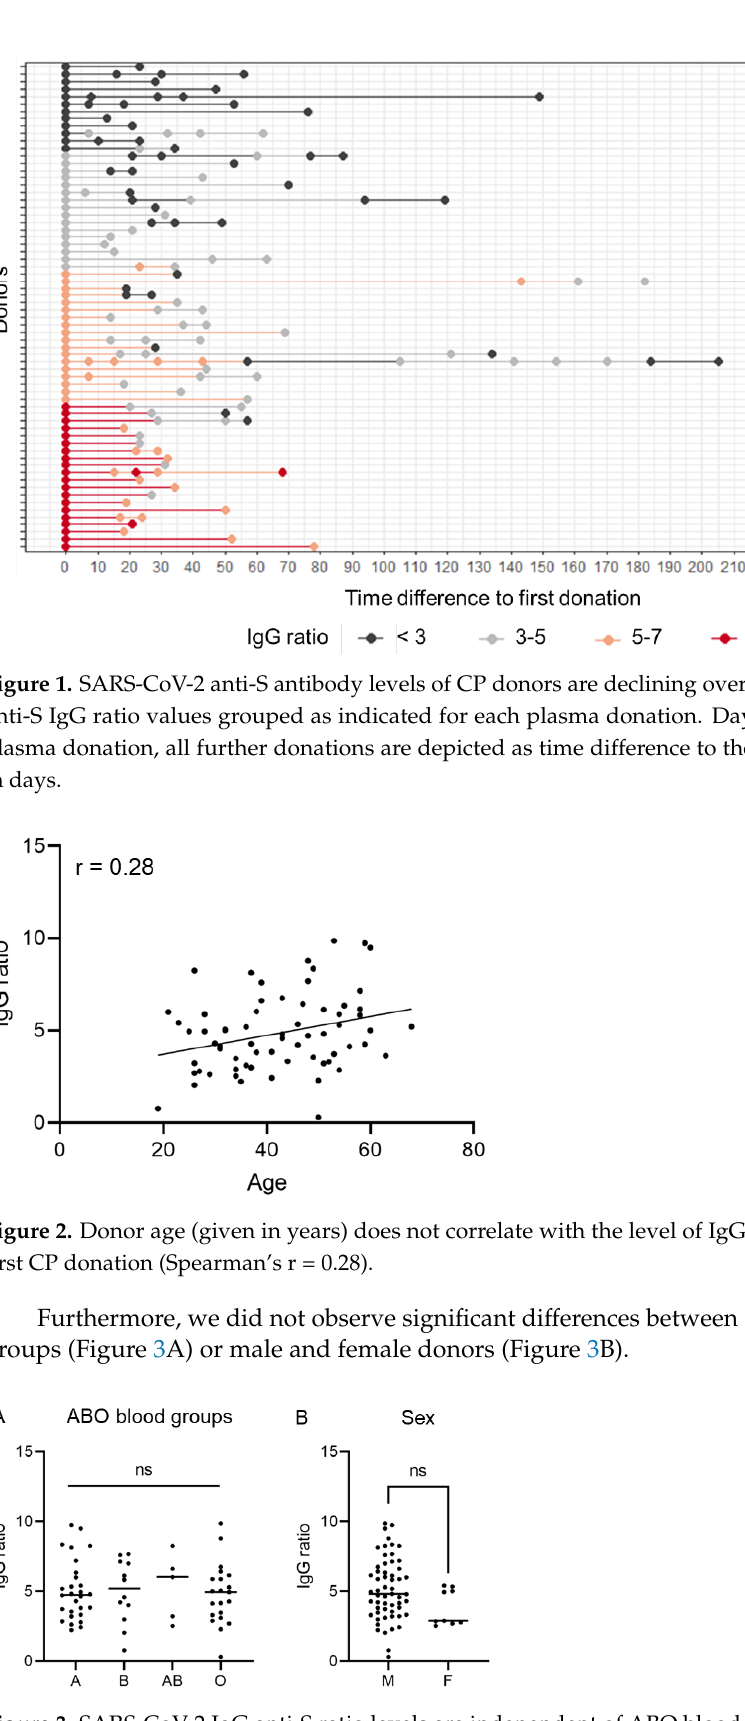
Figure 3. SARS-CoV-2 IgG anti-S ratio levels are independent of ABO blood group ( A ) and sex ( B ), male (M), female (F).